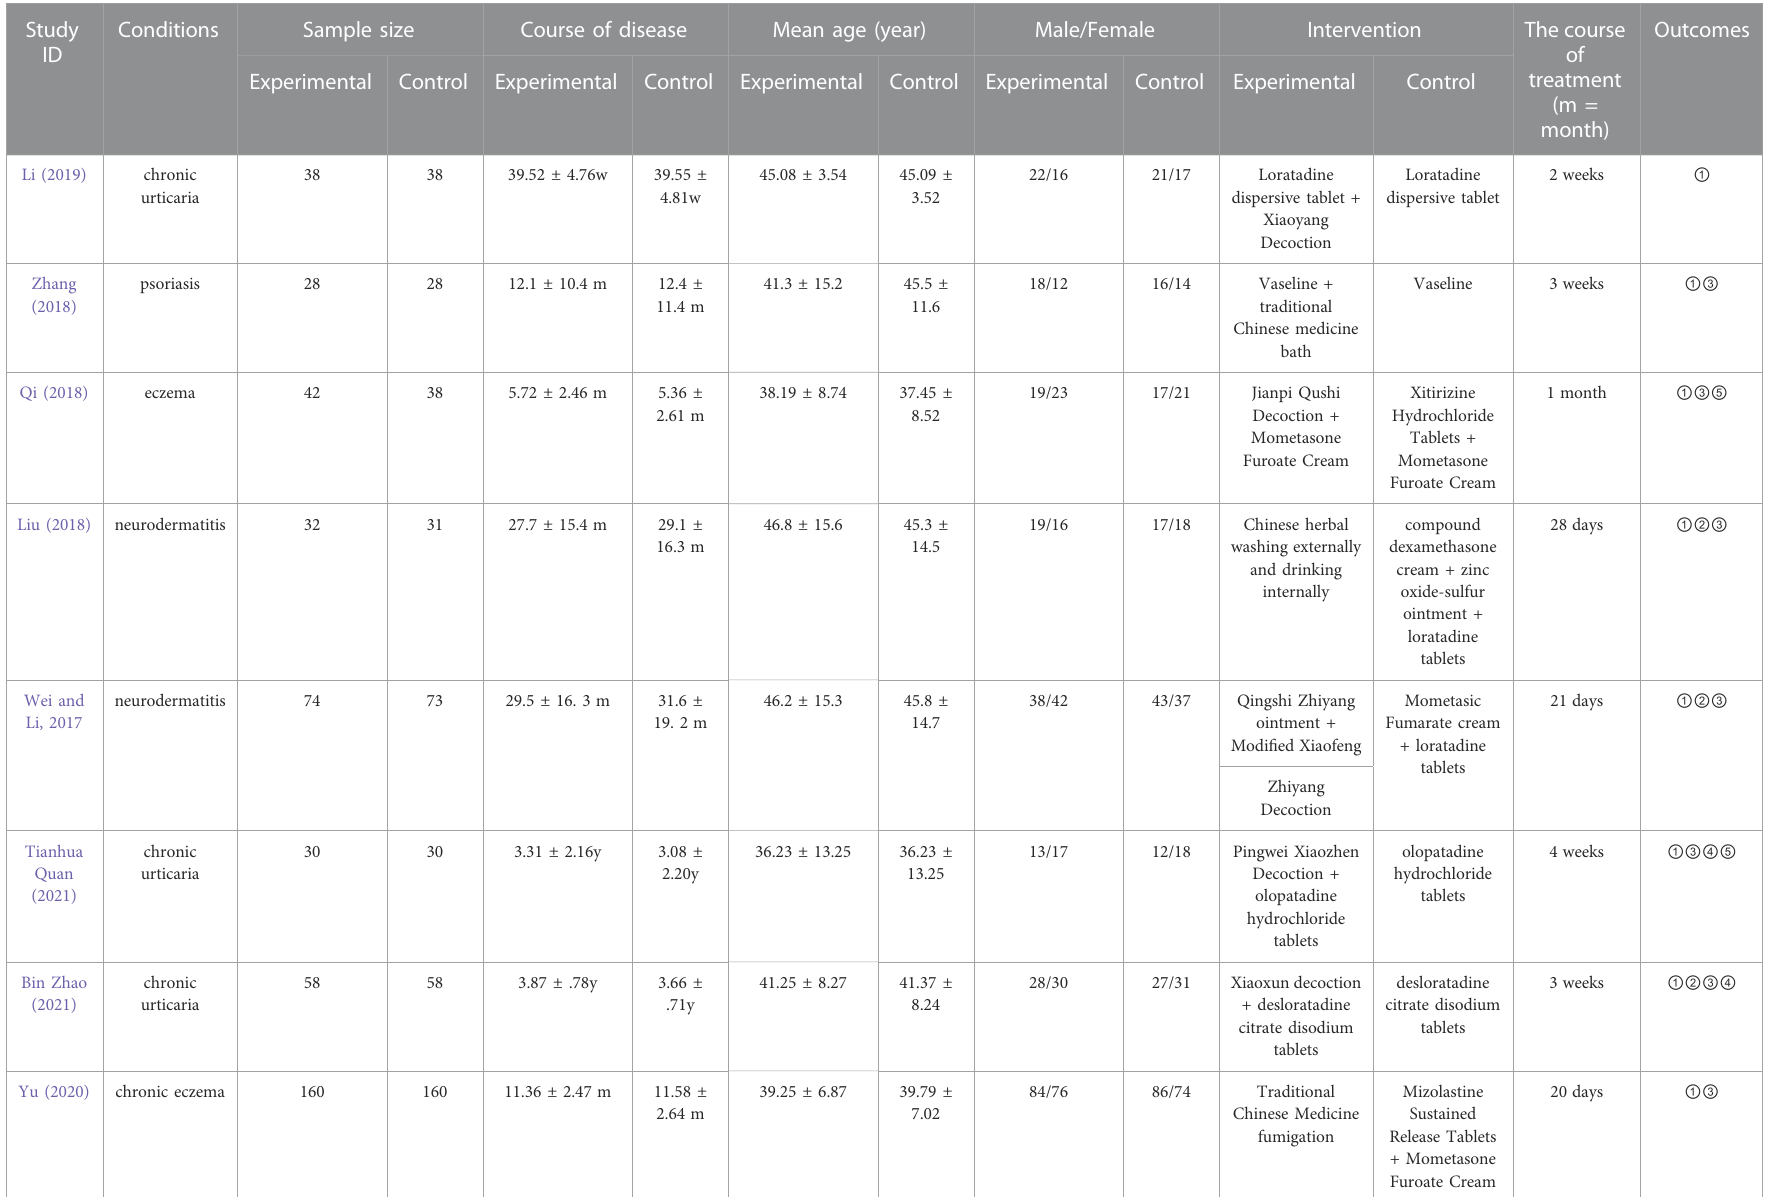
TABLE 2 Characteristics of the included